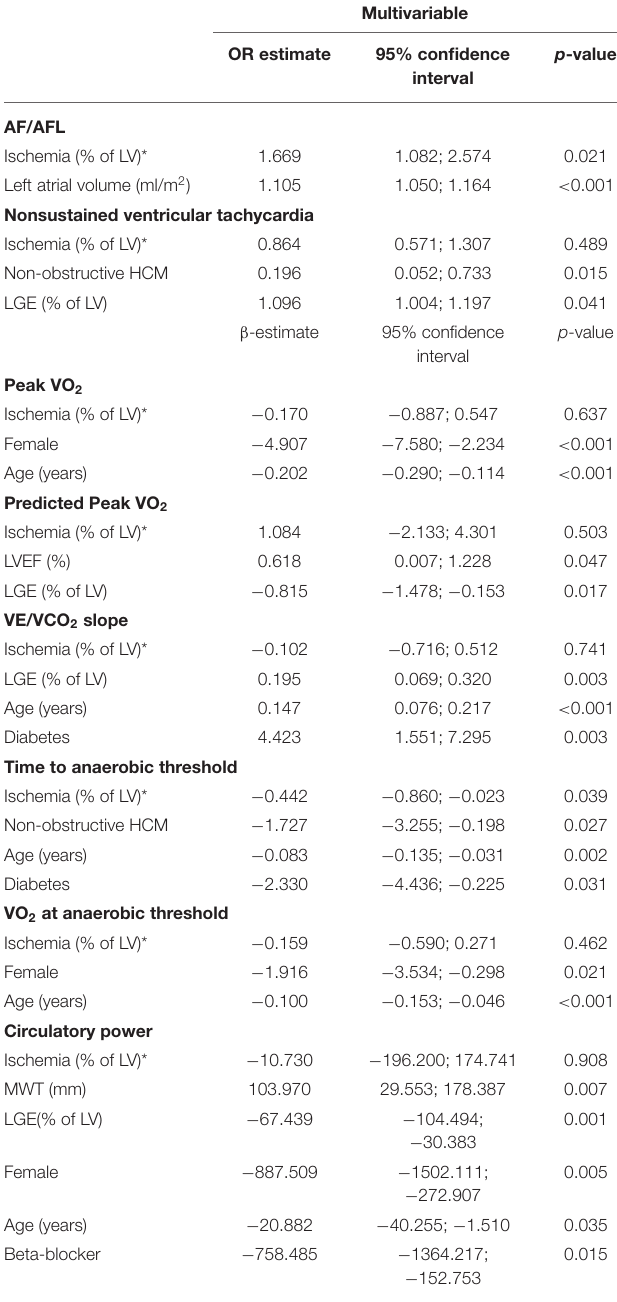
TABLE 5 | Multivariable logistic and linear regression for factors related to arrhythmias and functional